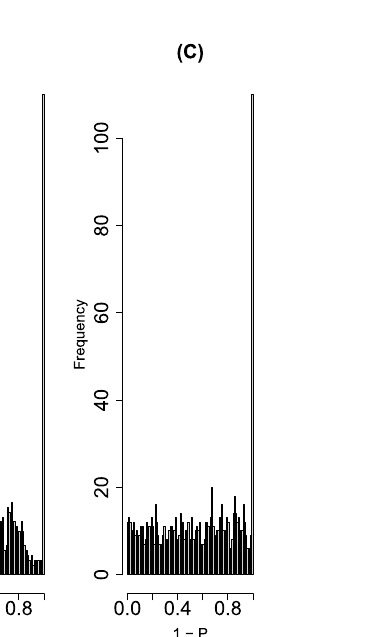
Figure 5. Histograms of 1 − P i , h ( 1 − P i ) , for ( A ) P i computed by Eq. (6) with σ defined in Eq. (20), ( B ) that with optimized SD, ( C ) that with true SD, σ = 1